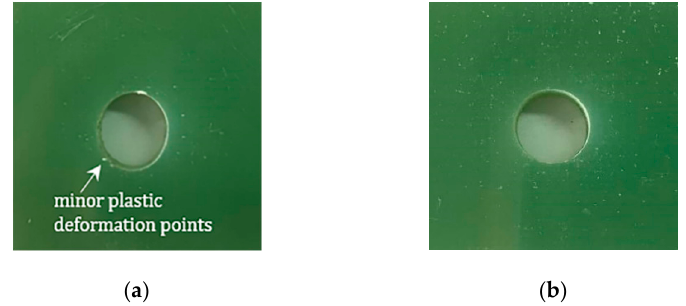
Figure 6. Plate surfaces of G-G connection after shear test. ( a ) GFRP connecting plate surface after shear test; ( b ) GFRP cover plate surface after shear test.